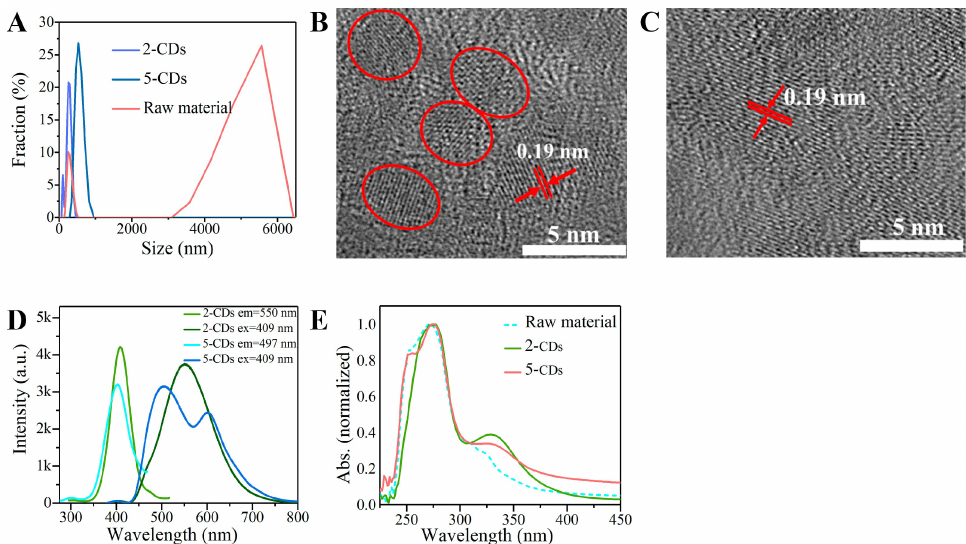
Figure 1. Appearance and optical characteristics of CDs. ( A ) Particle size distribution of CDs and raw material (2-methoxy-1, 4-naphthoquinone) in water. TEM images of 2 − CDs ( B ) and 5 − CDs ( C raw material (2-methoxy-1, 4-naphthoquinone) in water. TEM images of 2−CDs ( B ) and 5−CDs ( C ). ( D ) Fluorescence excitation and fluorescence emission spectra of CDs. ( E ) UV–vis absorption of CDs.